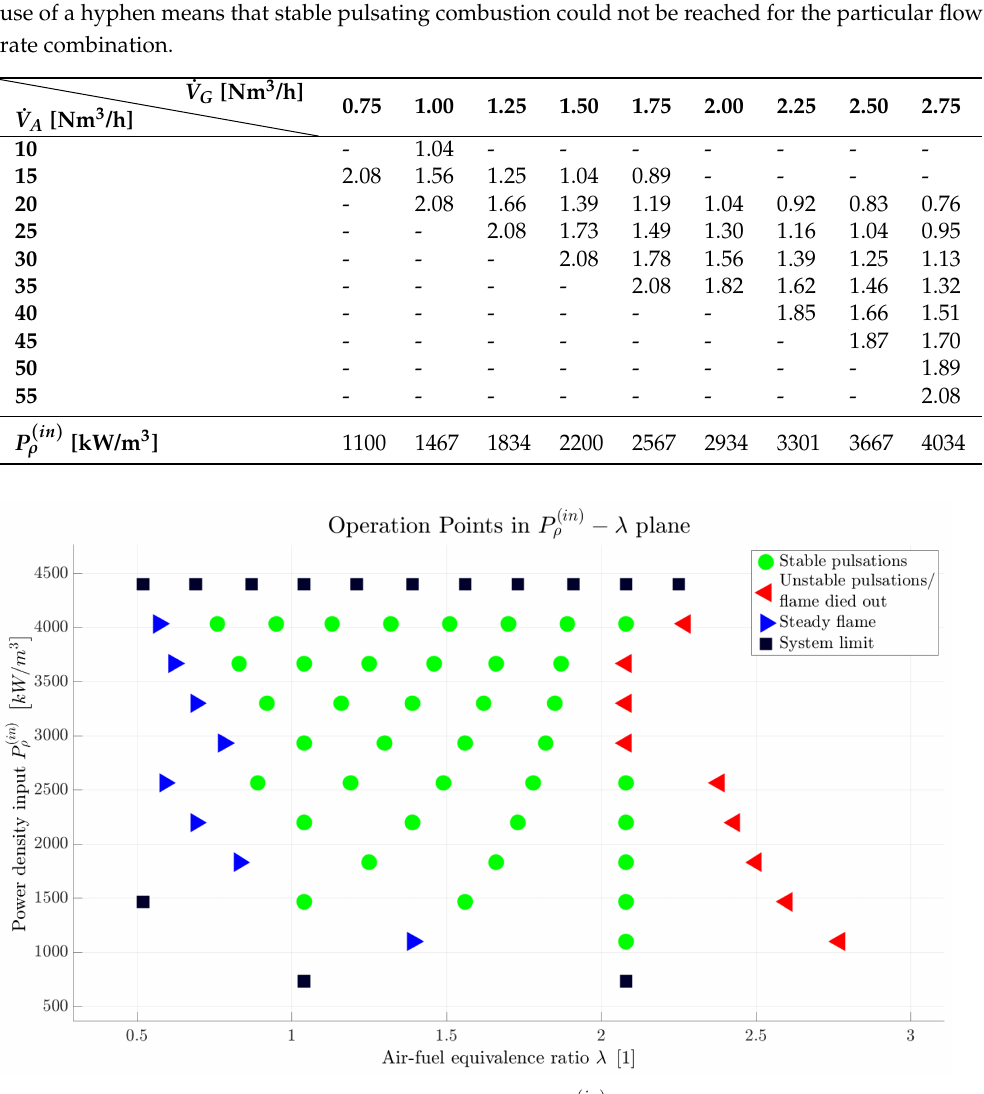
Figure 4. Operation points displayed graphically in the P always varied by the same value, the increment of the air–fuel equivalence ratio is not constant and alters depending on the power density input. Thus, the maximum λ for which stable pulsations were reached does not necessarily have to represent the operation limit. That applies primarily for lower ( in ) values of P ρ